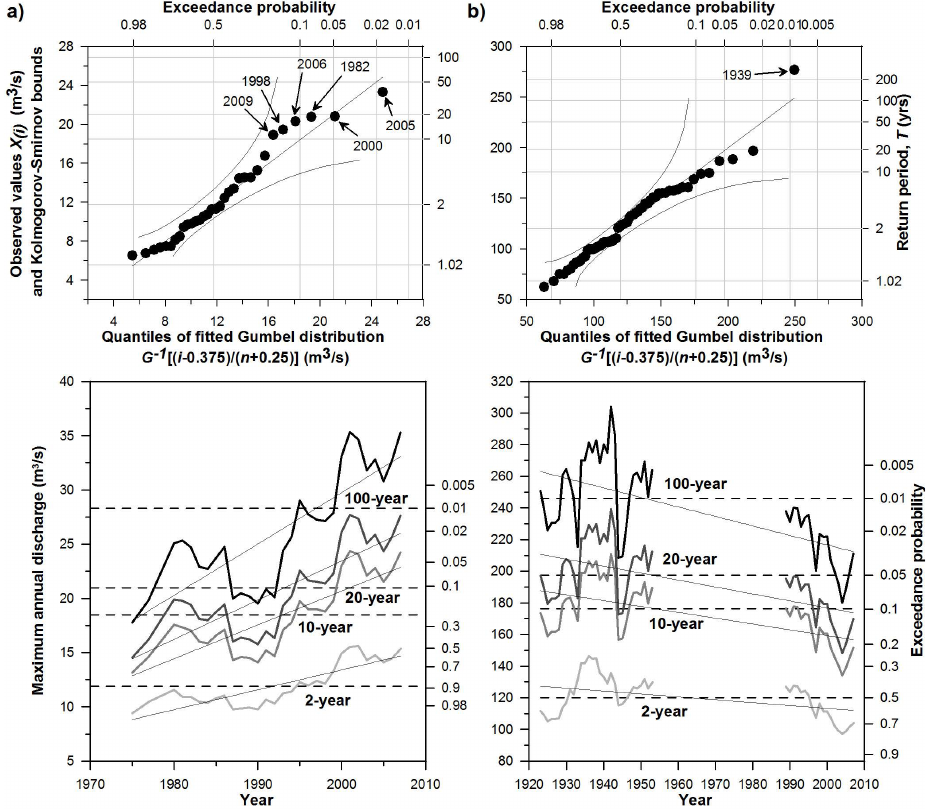
Fig. 5. Top graphs: Plots of annual maximum discharge for (a) Tarfala and (b) Abisko catchments versus quantiles of fitted Gumbel dis- tribution. Bottom graphs: Trends in the 2-yr, 10-yr, 20-yr, and 100-yr return periods (50th, 90th, 95th, and 99th percentile) of the annual maximum flood for the (a) Tarfala and (b) Abisko catchments. Flood records were tested for stationarity by fitting a generalized least squares regression to 10-yr moving window estimated flood quantiles versus calendar year and determining the significance of the regression slope at a significance level of 5%. The solid lines indicate linear trends in the flood records. Dashed lines represent the percentiles estimated from the full